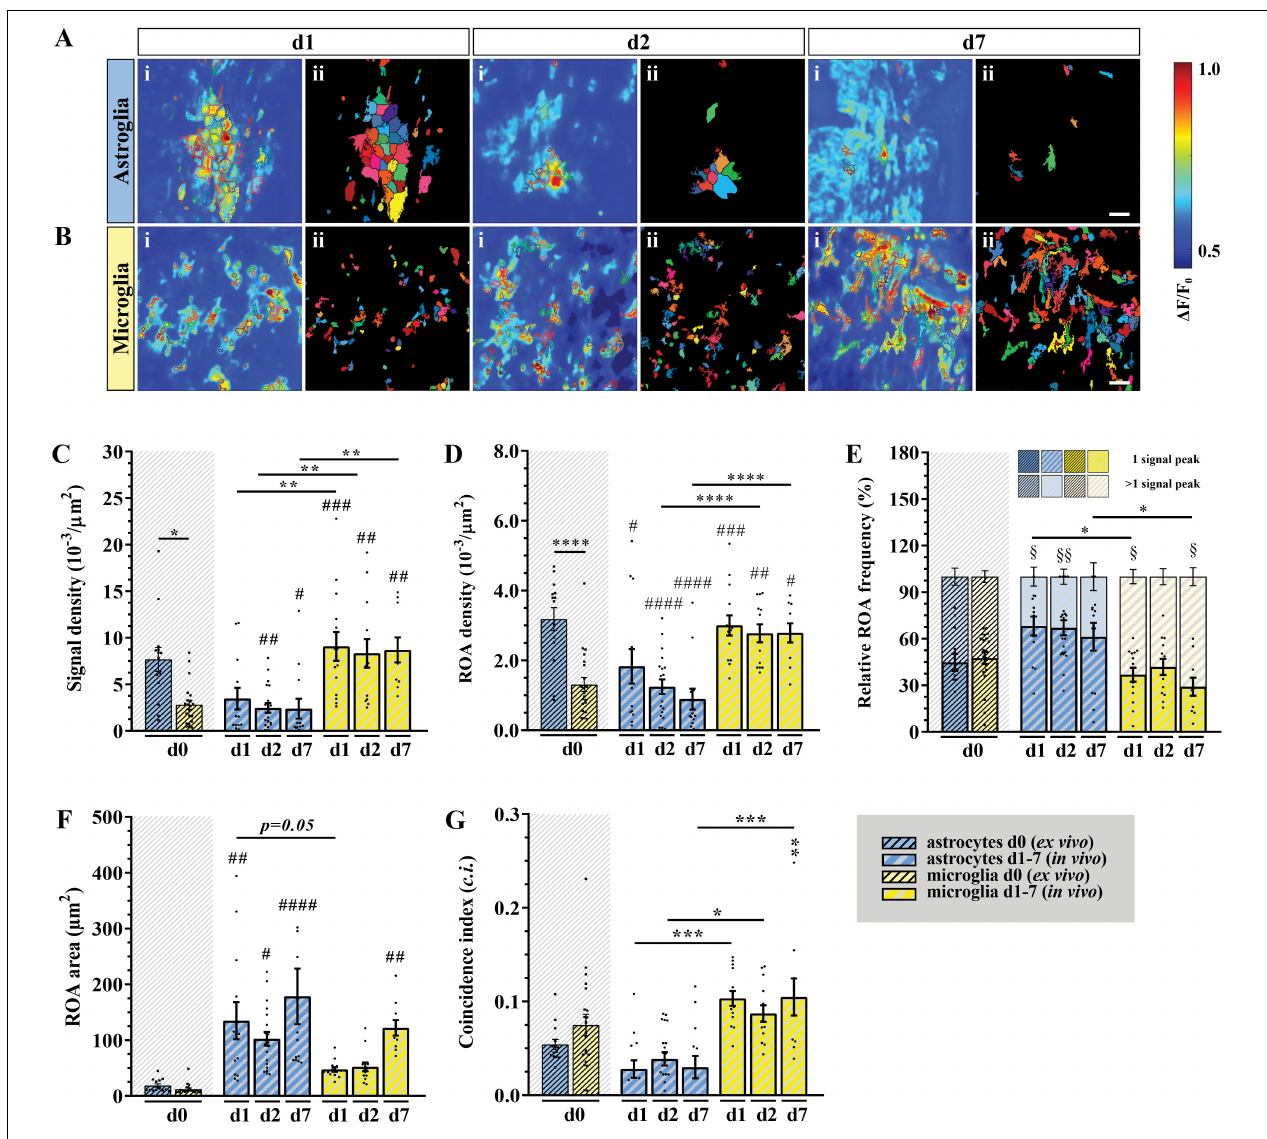
FIGURE 5 | In vivo microglial Ca 2 + signals showed higher signal and ROA densities as well as smaller areas and a higher temporal coincidence. (A,B) Automatic detected ROAs based on absolute fluorescence projections along the temporal axis for astroglia (blue) and microglia (yellow) in vivo ( d1 , d2 and d7 , wm ). Absolute fluorescence projections (i) were overlapped with the edges of the detected ROAs [depicted as solid areas in panel (ii)]. (C) Signal and (D) ROA density. (E) Relative frequency of ROAs active once (lower bars) or more than once (upper bars) over the recording time. (F) ROA area and (G) mean relative number of simultaneously active ROAs over the total recording time calculated as coincidence index ( c.i. ). Ex vivo ( d0 ) wm data were placed next to the in vivo data for direct comparison. (C–G) Data were represented as mean ± SEM of single FOVs. Single datasets were analyzed using a Shapiro–Wilk normality test and represented as FOV medians. Data were compared using an Ordinary one-way ANOVA with Bonferroni’s multiple comparisons test. Comparisons between in vivo and ex vivo data were displayed on top of the single bars. For each group in panel (E) , the relative numbers of ROAs presenting one or more signal peaks were analyzed using a Wilcoxon